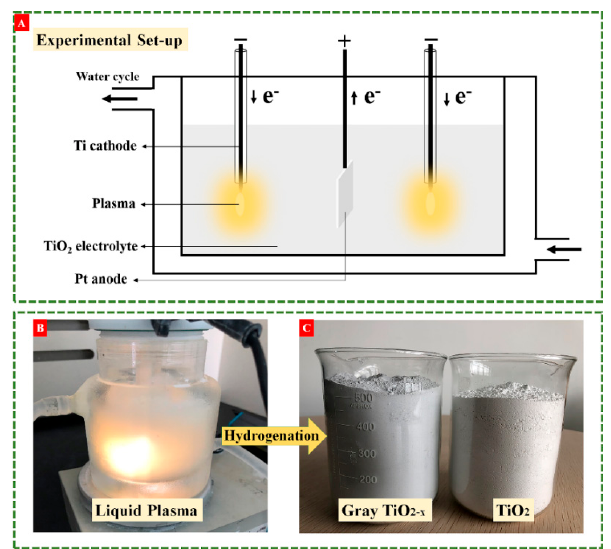
Figure 1. ( A ) The setup for liquid plasma generation, ( B ) digital picture of as-produced liquid plasma, and ( C ) digital pictures for gray titanium dioxide (TiO 2 − x ) and pristine white TiO 2 .